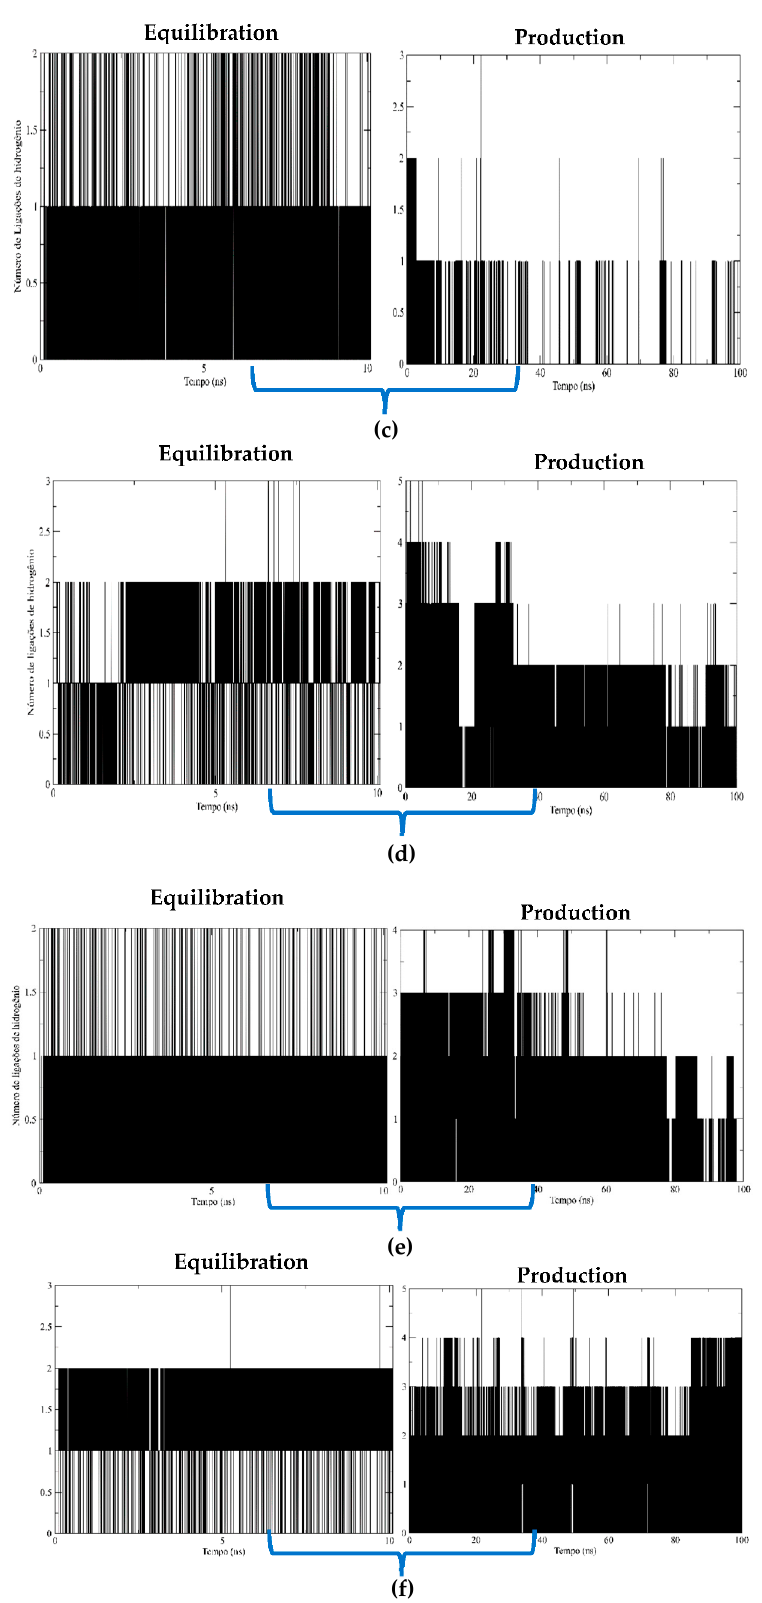
Figure 6. Hydrogen bonds formed between the protein and the ligand during the two simulation steps. ( a ) Octanoic acid; ( b ) Decanoic acid; ( c ) Dodecanoic acid; ( d ) Tetradecanoic acid; ( e ) Hexadecanoic acid; ( f ) cis -9-octadecenoic